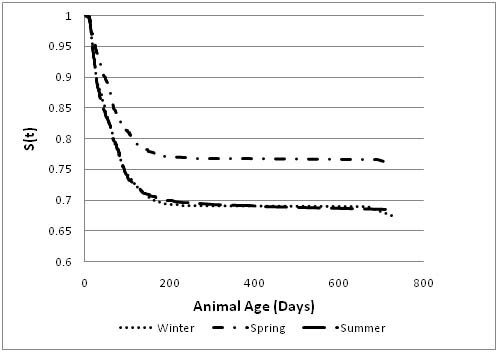
Kaplan-Meier survivorship curve for the probability of not shedding Giardia passed certain age for animals enrolled in the study and grouped by season of the year. The data was restricted to a follow-up period of 730 days.